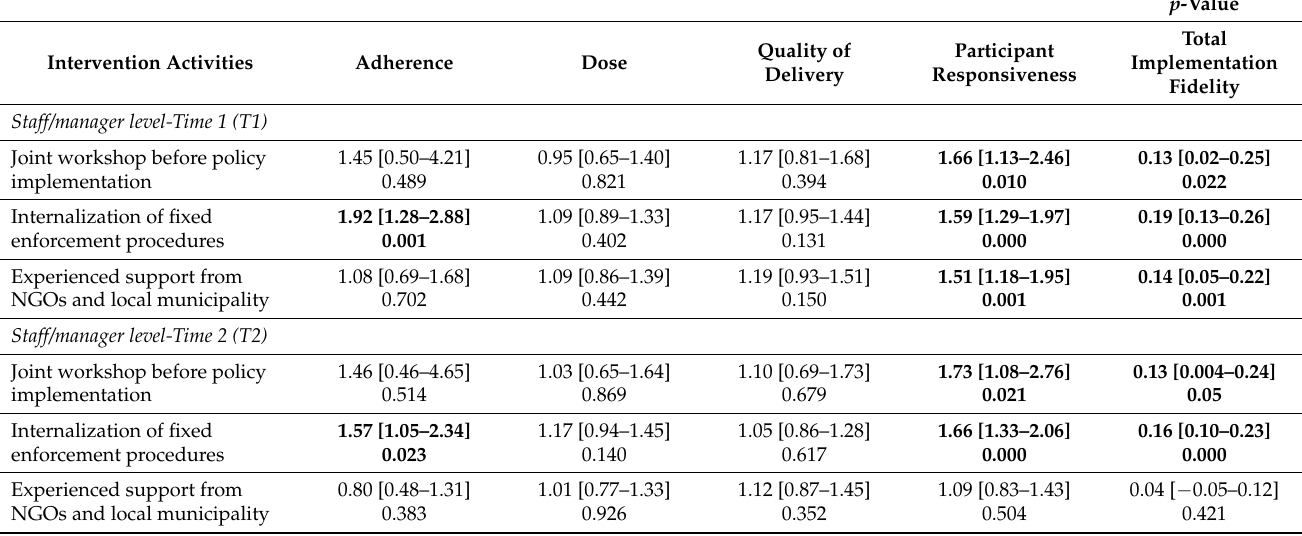
Table 8. Staff/manager level associations between intervention activities and implementation fidelity of the smoke-free school hours policy, across T1 and T2. The models are adjusted for age, sex, smoking status, and if they had a special function in relation to health